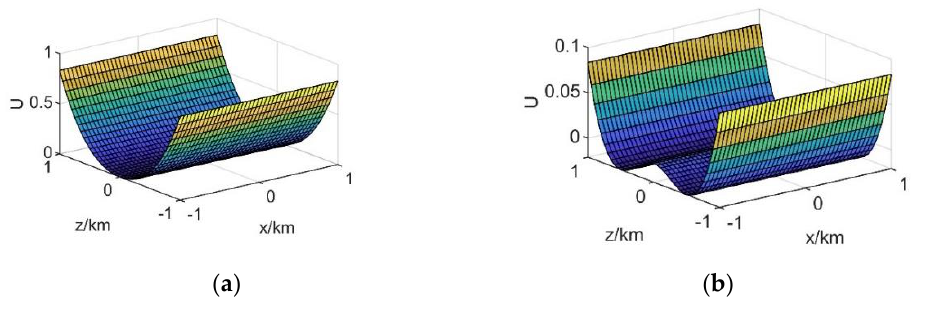
Figure 10. Bifurcating potential field ( k f = 1 kg/kms 2 , a = 1, b = 0). ( a ) Line potential field ( µ = − 1 km); ( b ) Double line potential field ( µ = 0.5 km).